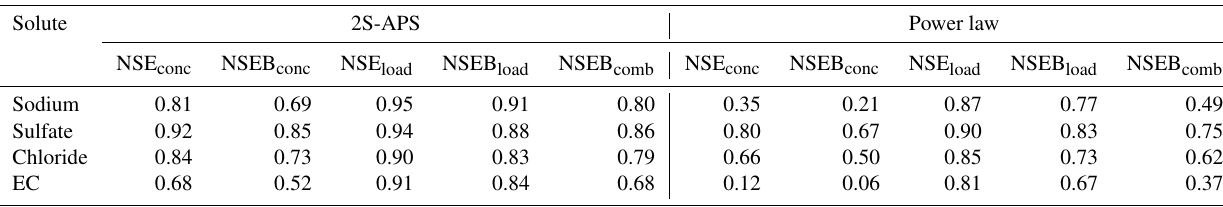
Table 7. NSE criteria computed for the three ions and EC.